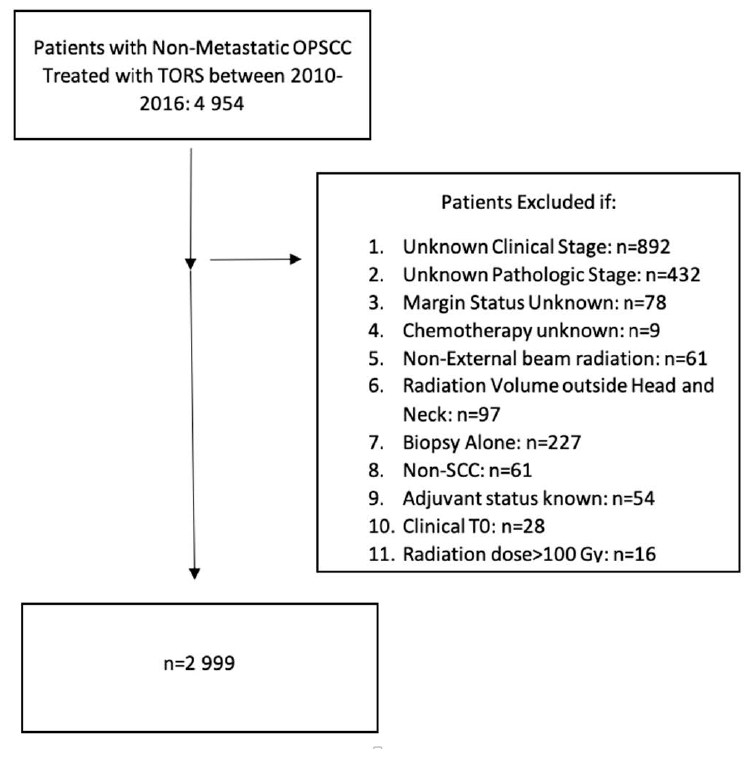
Figure 1. Selection criteria. Table 1. Patient